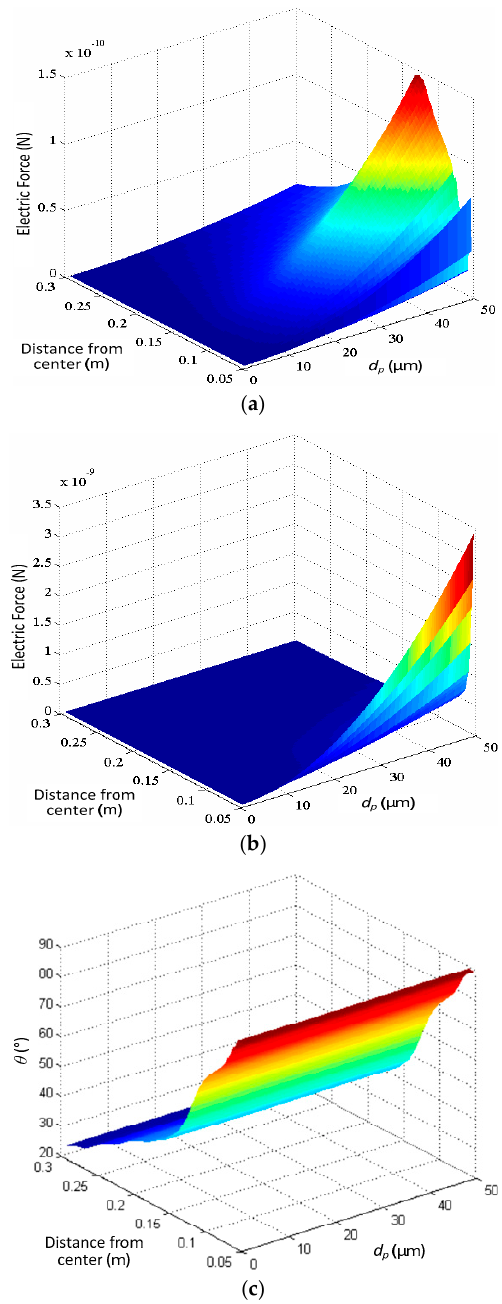
Figure 3. Electric field force performance near the insulator string. ( a ) The horizontal component of electric force; ( b ) The vertical component of electric force; and ( c ) θ °, the angle between of electric force and horizontal direction.